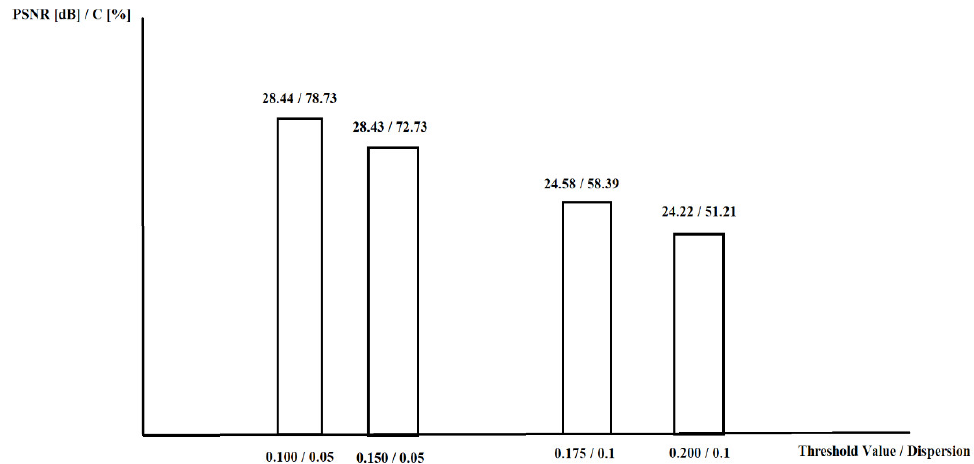
Figure 4. PSNR and C dependence on the threshold value and noise dispersion (according to data presented in Appendix A).